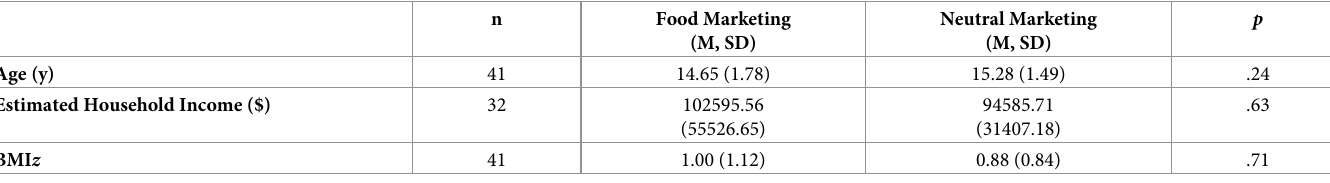
Table 1. Participants characteristics based on